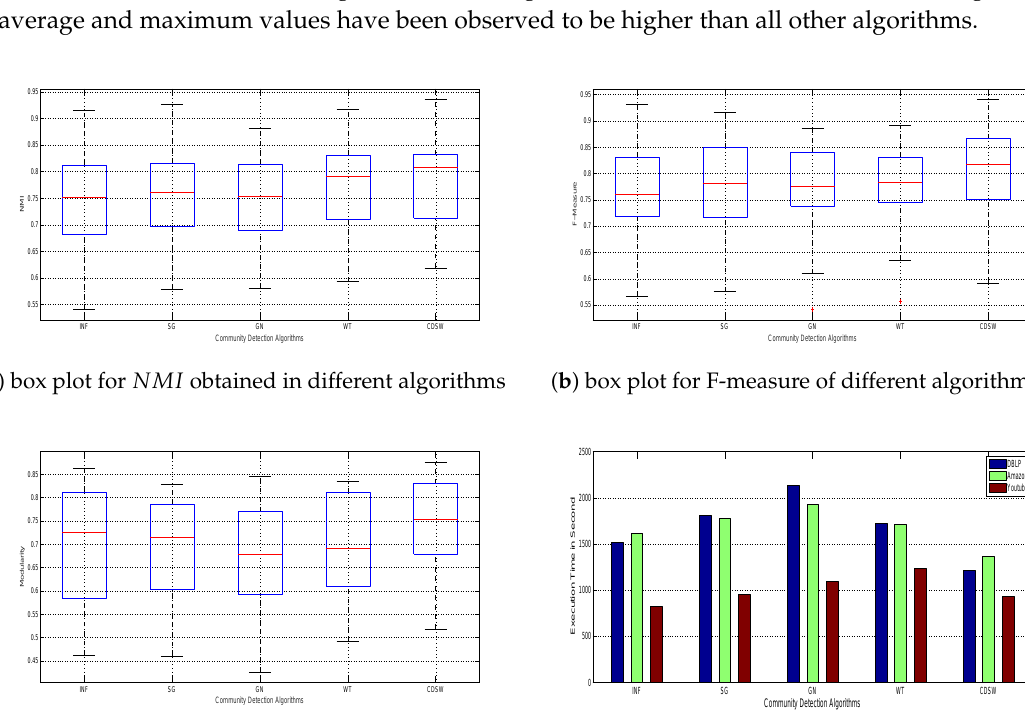
( c ) box plot for modularity obtained in different algorithms ( d ) execution time comparison in real-time datasets Figure 3. Comparative study of different community detection